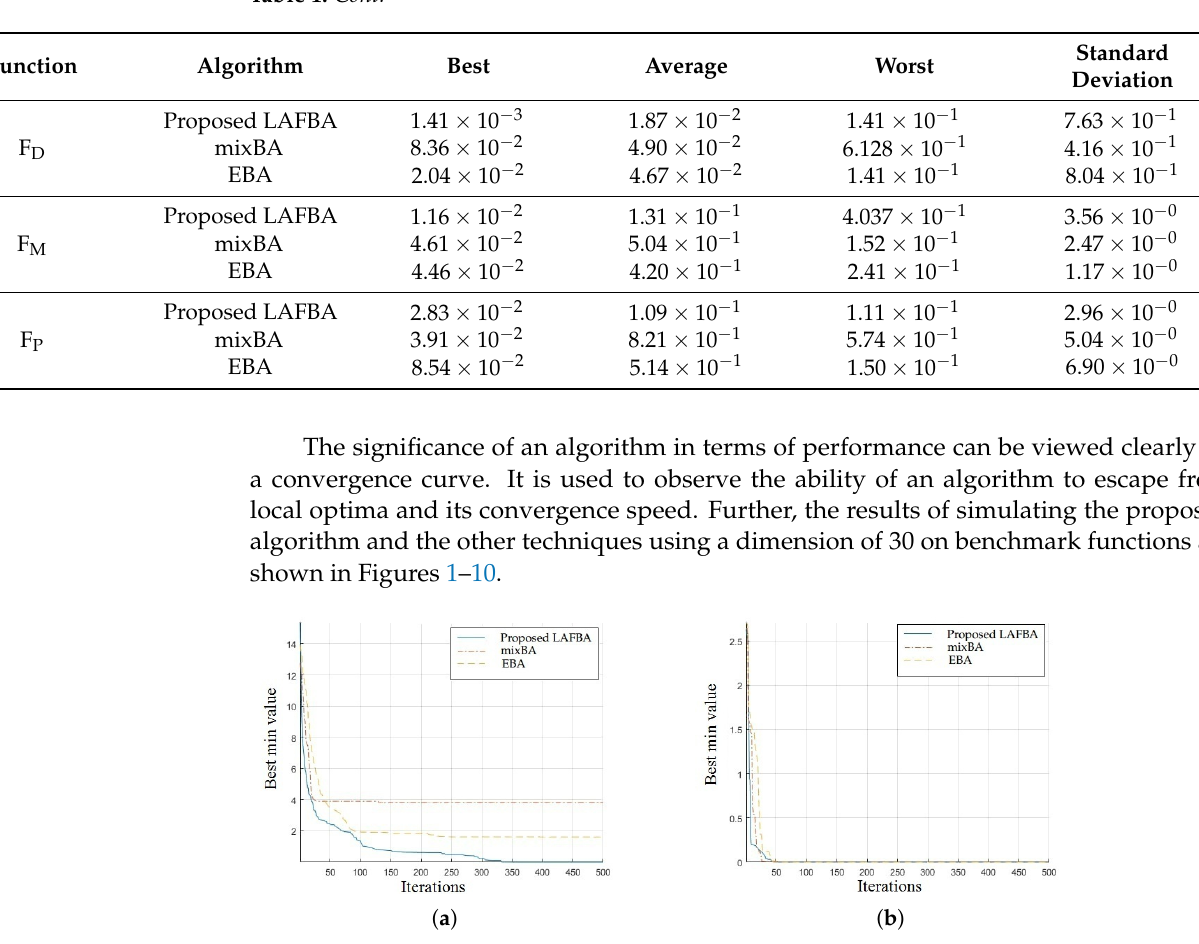
Figure 1. ( a ) Salomon’s function convergence graph. ( b ) Sum of different power functions.